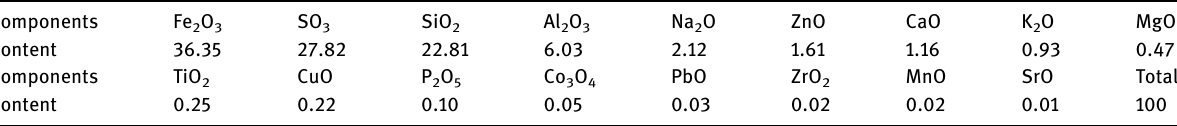
Table 2: Chemical composition of the copper ore tailings ( wt% )